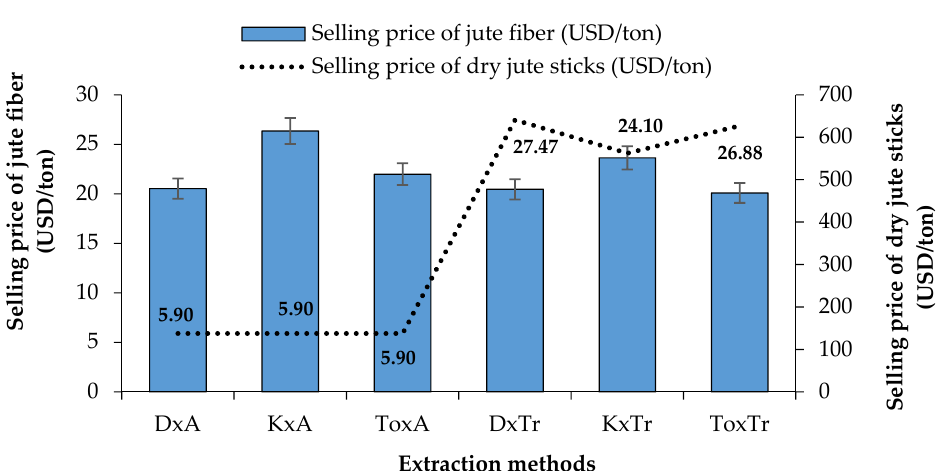
Figure 17 . Interaction effect of extraction methods and jute types on selling price of jute fiber and stick.